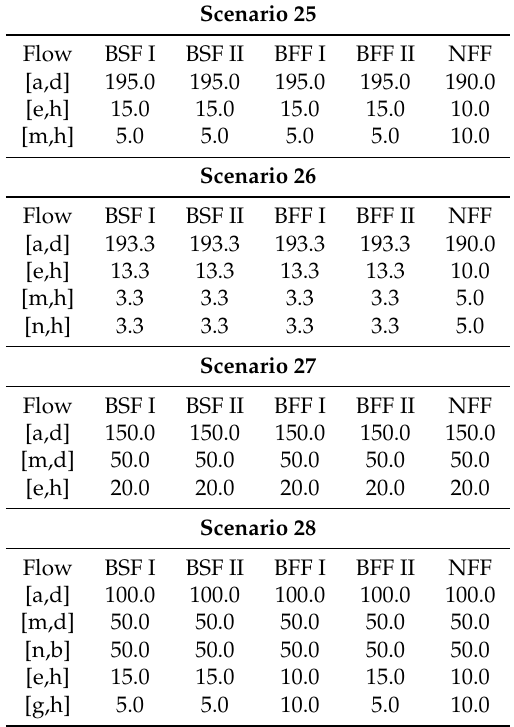
Table 8. Flow set and LP results for the flows’ end-to-end throughput for scenarios 25 to 28 described in Figure 19. All values in Mbps.